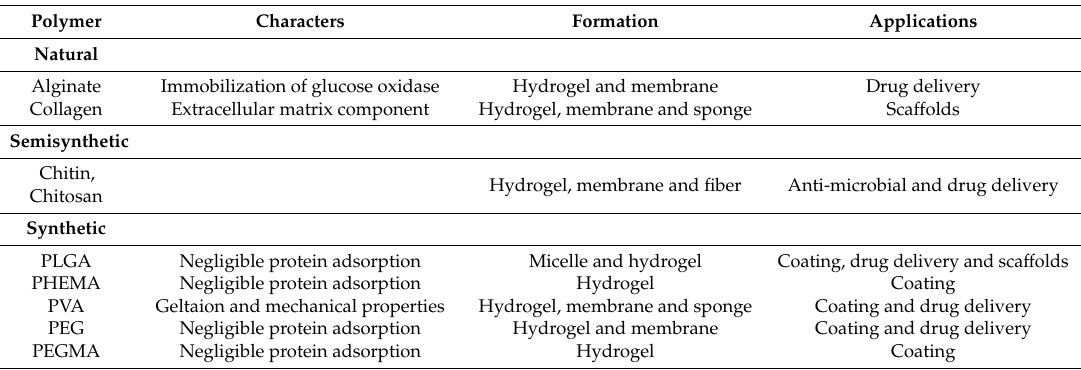
Table 1. Biochemical aspects of commonly used